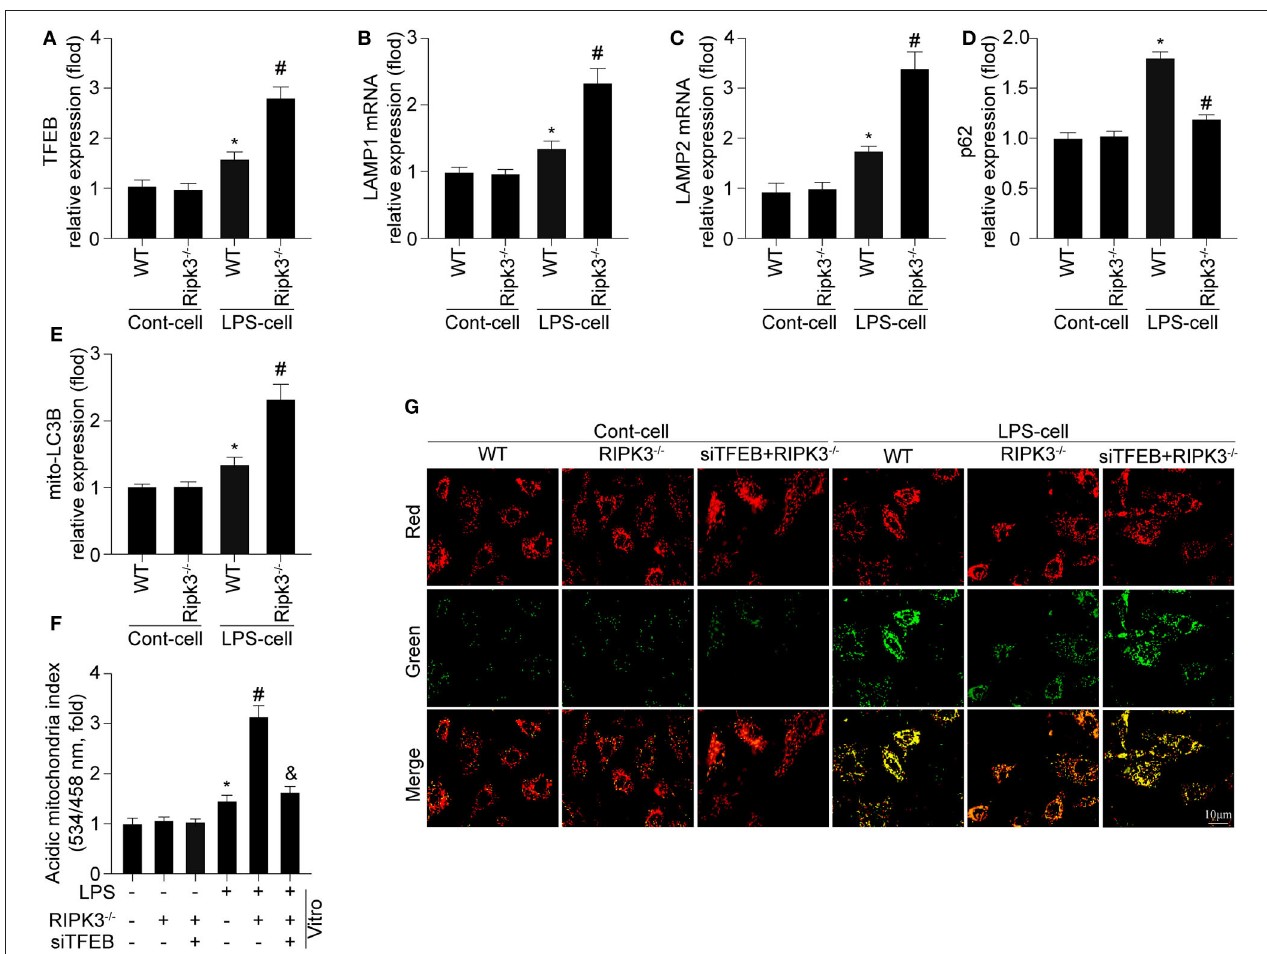
FIGURE 4 | Mitophagy is modified by RIPK3 in a manner dependent on TFEB expression ( n = 6/group). (A) Cardiomyocytes were isolated from WT and Ripk3 − / − mice and then treated with LPS (5 µ g/ml) to induce sepsis-related cardiomyocyte damage. The expression of TFEB was measured via western blot. (B,C) The alteration of LAMP1 and LAMP2 mRNA expression were measured via qRT-PCR. (D,E) mito-LC3B and p62 were measured via western blot. (F) siRNA against TFEB (si-TFEB) was transfected into RIPK3 − / − cells to reduced TFEB expression under LPS challenge. 1Ψ m was measured by JC-1 assay. (G) Mitophagy activity was observed using the mt-Keima assay. * p < 0.05 vs. WT group. # p < 0.05 versus WT + LPS group. & p < 0.05 vs LPS + RIPK3 − / − group.